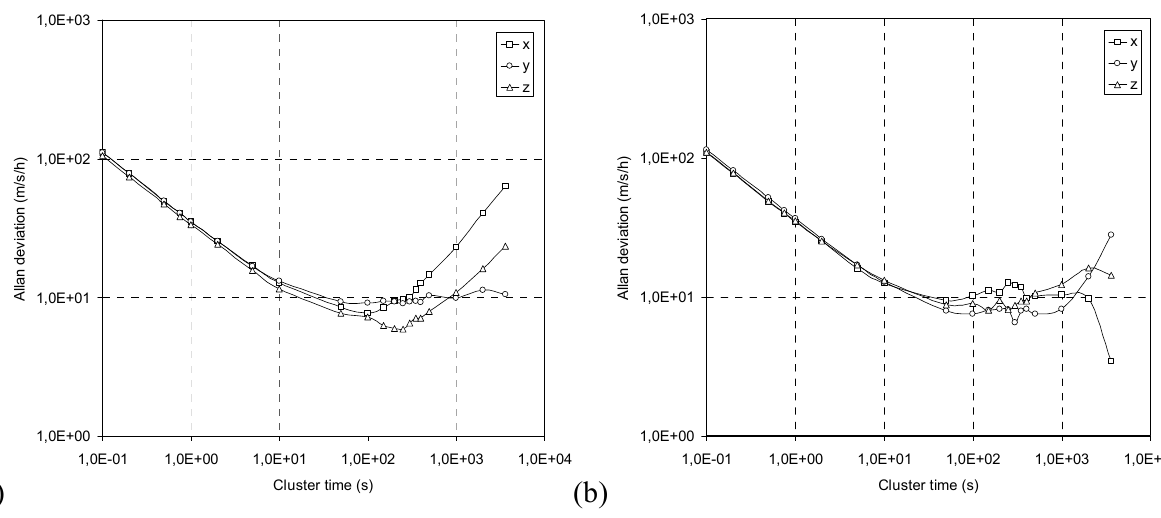
Figure 6. Allan deviation curves for acceleration signal calculated for each axis before (a) and after (b) the vibration